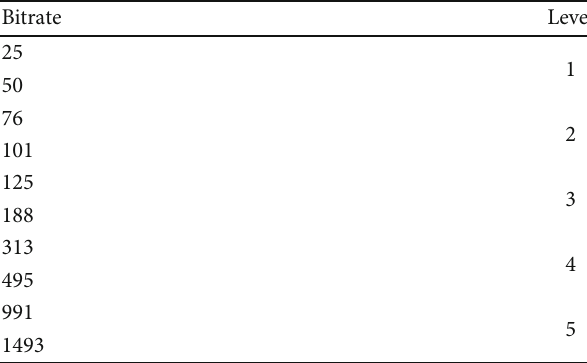
Figure 3: Request and response headers after requesting a segment and receiving it. Table 1: Features extracted from the log requests of the web service.